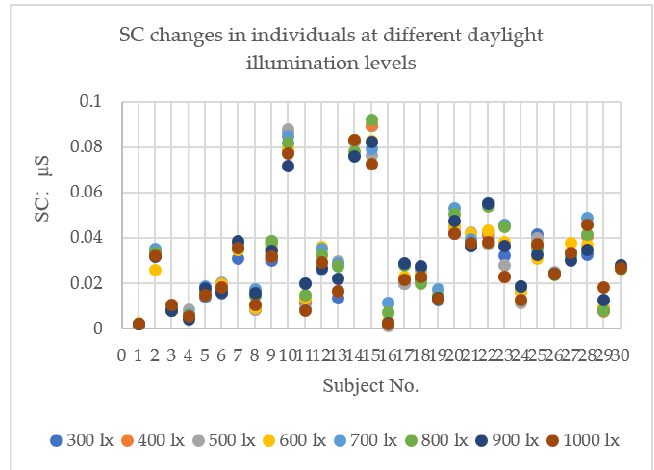
Figure 9. SC changes in individuals at different daylight illumination levels.